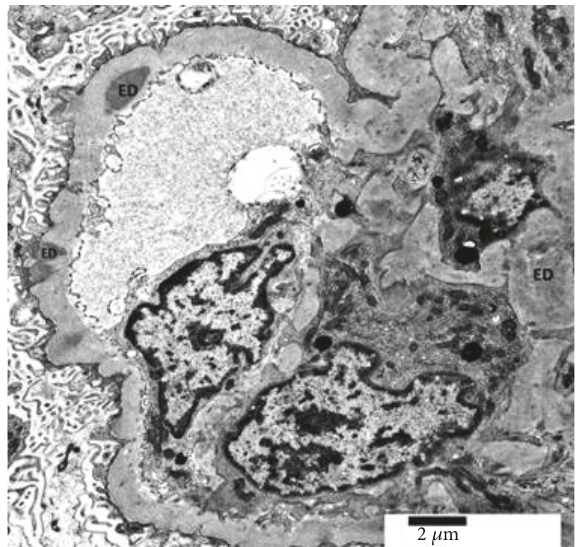
Figure 6: There is mesangial hypercellularity and mild thickening of glomerular basement membrane along with electron dense deposits (ED) in mesangial, subendothelial, and subepithelial locations (electron microscopy, x 8000).